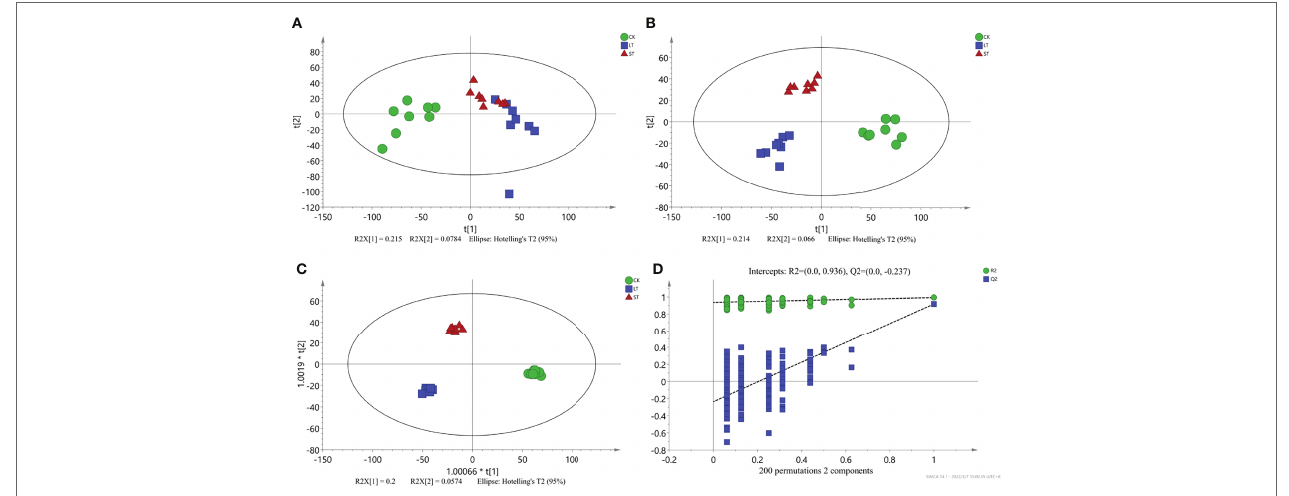
FIGURE 6 | Derived principal component analysis (PCA) score plot, partial least squares-discriminant analysis (PLS-DA) score plot, orthogonal projections for latent structures (OPLS-DA) score plot, and permutation test plot of OPLS-DA from the UPLC-Q-TOF-MS metabolite profiles. (A) PCA score plot of metabolite profiles from the LT, ST, and CK. (B) PLS-DA score plot in the LT vs. ST vs. CK. (C) OPLS-DA score plot in the LT vs. ST vs. CK. (D) Permutation test plot of OPLS-DA in the LT vs ST vs. CK. CK control; ST, short-term acidification; LT, long-term